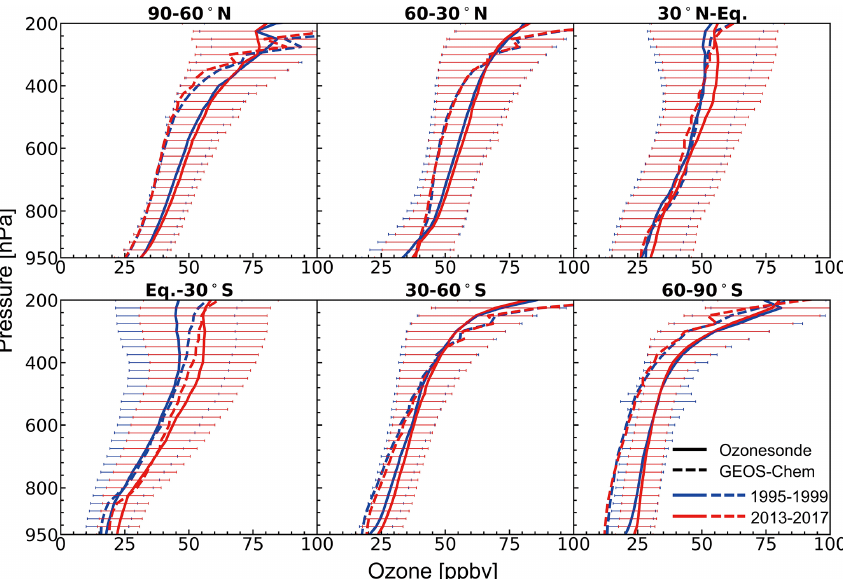
Figure 4. Comparison of ozonesonde (solid line) and simulated (dashed line) ozone vertical profiles for six zonal bands over 1995–1999 (blue line) and 2013–2017 (red line). Horizontal bars are standard deviations in the observation.